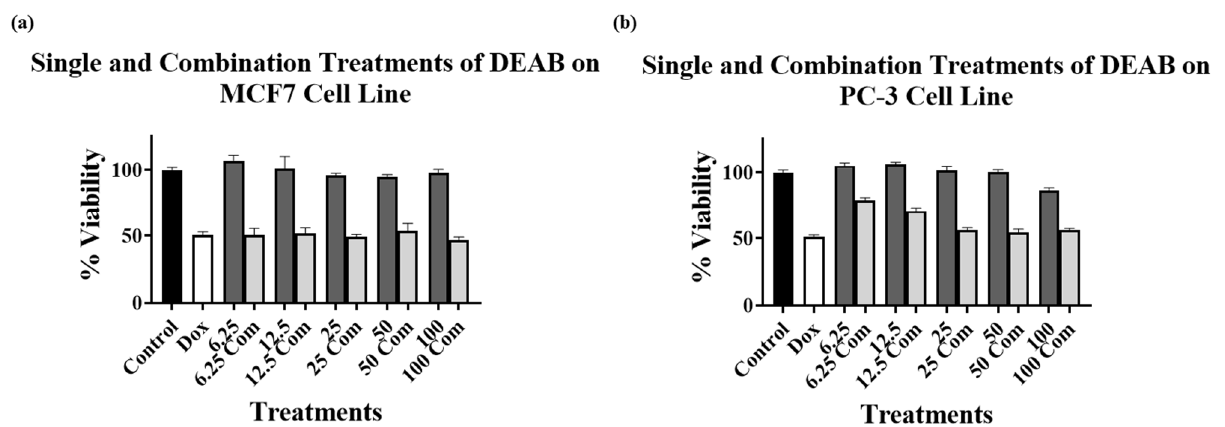
Figure 5. Cell viability assays using DEAB on ( a ) MCF7 and ( b ) PC-3 cell lines alone at various concentrations (dark grey bars) and in combination with ( a ) 5 μ M DOX and ( b ) 1 μ M DOX (light grey bars). Control bar charts (black bars) mean no treatments were added. DOX at ( a ) 5 μ M and ( b ) 1 μ M alone are presented as white bars. Experiments were performed in triplicates in three independent experiments with controls.